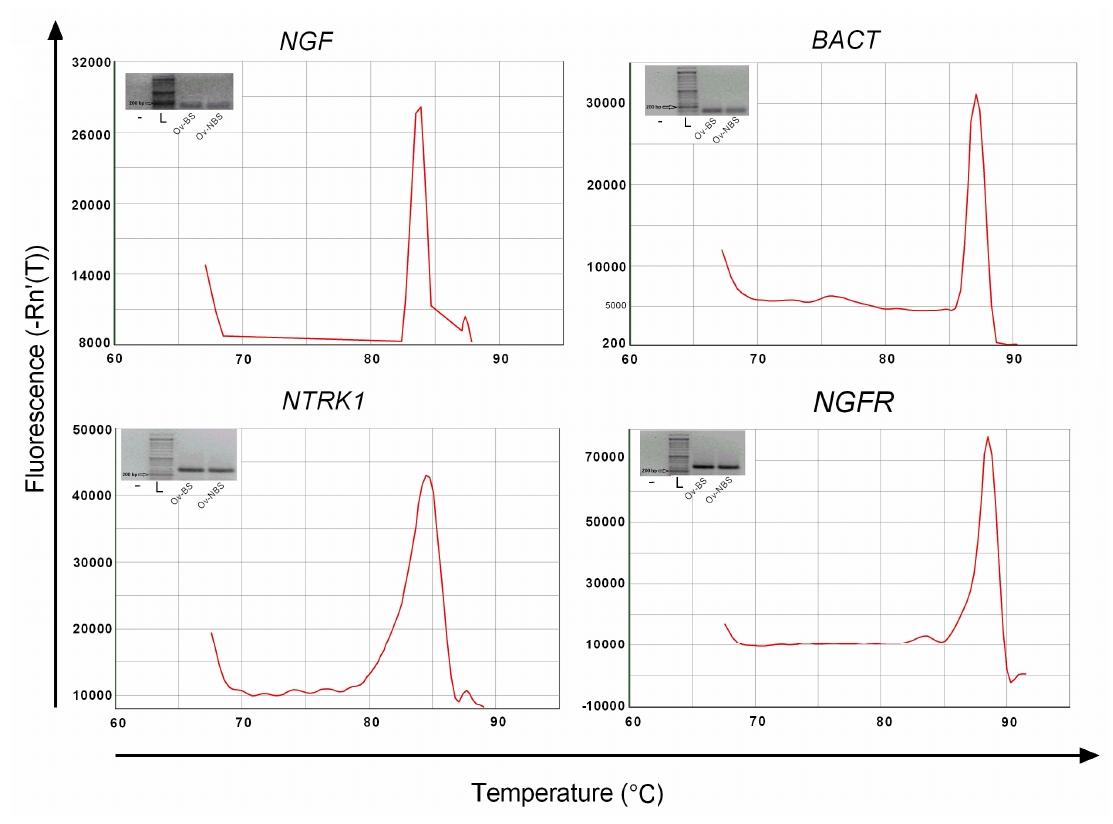
Figure 3. Specificity of primers and amplicon length. Both the presence of a single band with the expected size in 1.2% agarose gel electrophoresis and the single peak of dissociation curves indicate that the PCR products were specific. Bp: base pairs; − : negative control; L: ladder; Ov-BS: ovary—breeding season; Ov-NBS: ovary—nonbreeding season; NGF : nerve growth factor, NTRK1 : neurotrophic tyrosine kinase receptor 1; NGFR : nerve growth factor receptor target genes; BACT : β -actin housekeeping